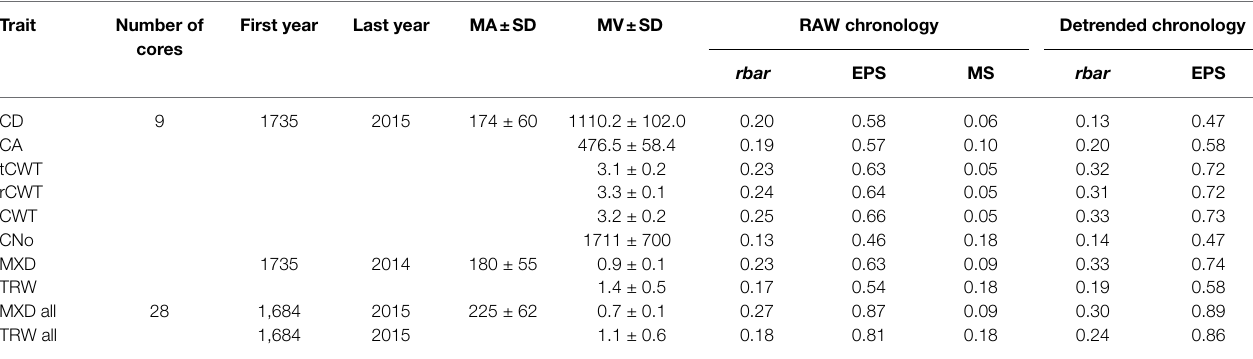
TABLE 1 | Main statistical parameters for raw and detrended xylem traits chronologies. Trait Number of